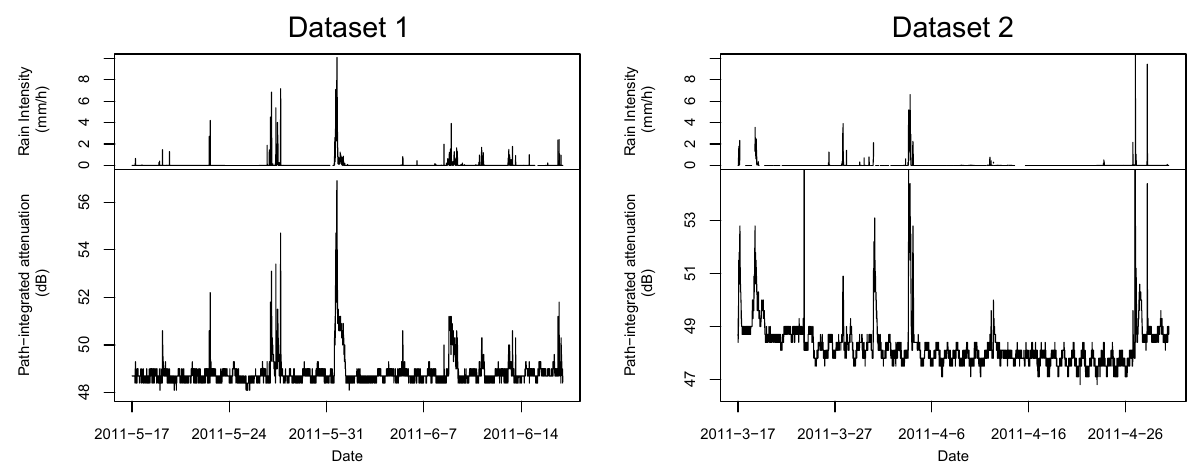
Fig. 2. Rain rate [mmh − 1 ] and path-integrated attenuation [dB] for dataset 1 (stationary) and 2 (non-stationary). For better illustration, only the attenuation of channels 1 (dataset 1), and 4 (dataset 2) are shown. The time is given in UTC.